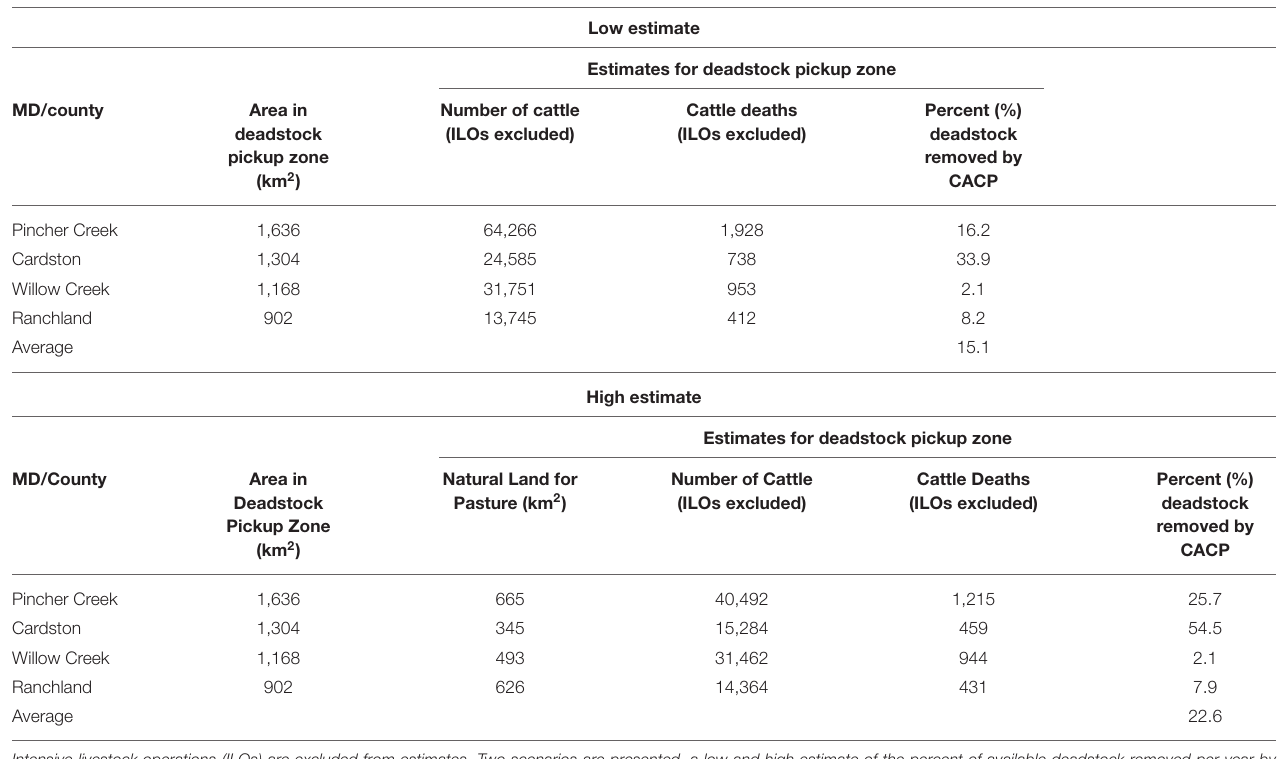
TABLE 3 | Estimated number of cattle and cattle deaths occurring in the Carnivores and Communities Program (CACP) deadstock pickup zone each year in southwestern